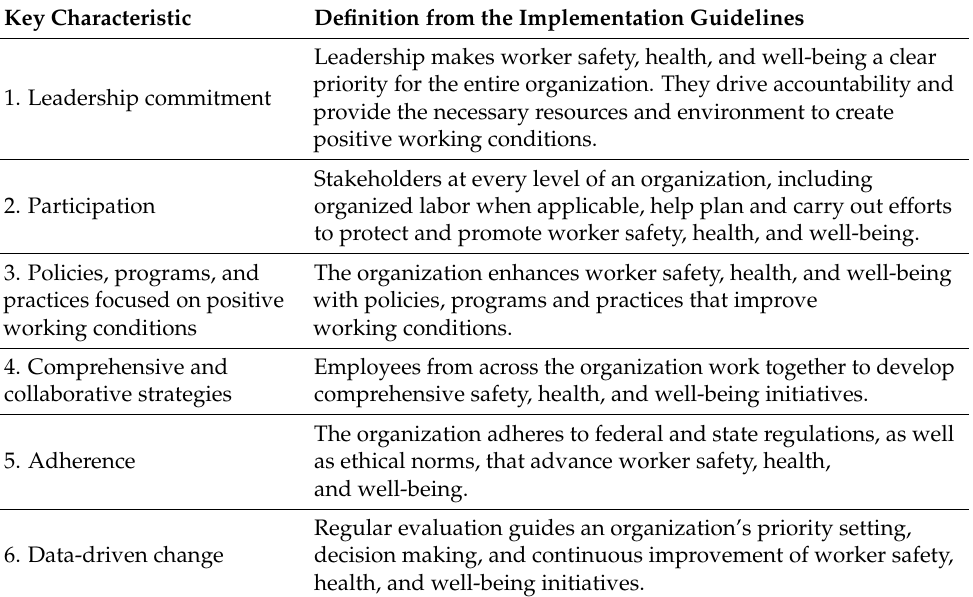
Table 1. Six key characteristics of a TWH integrated approach